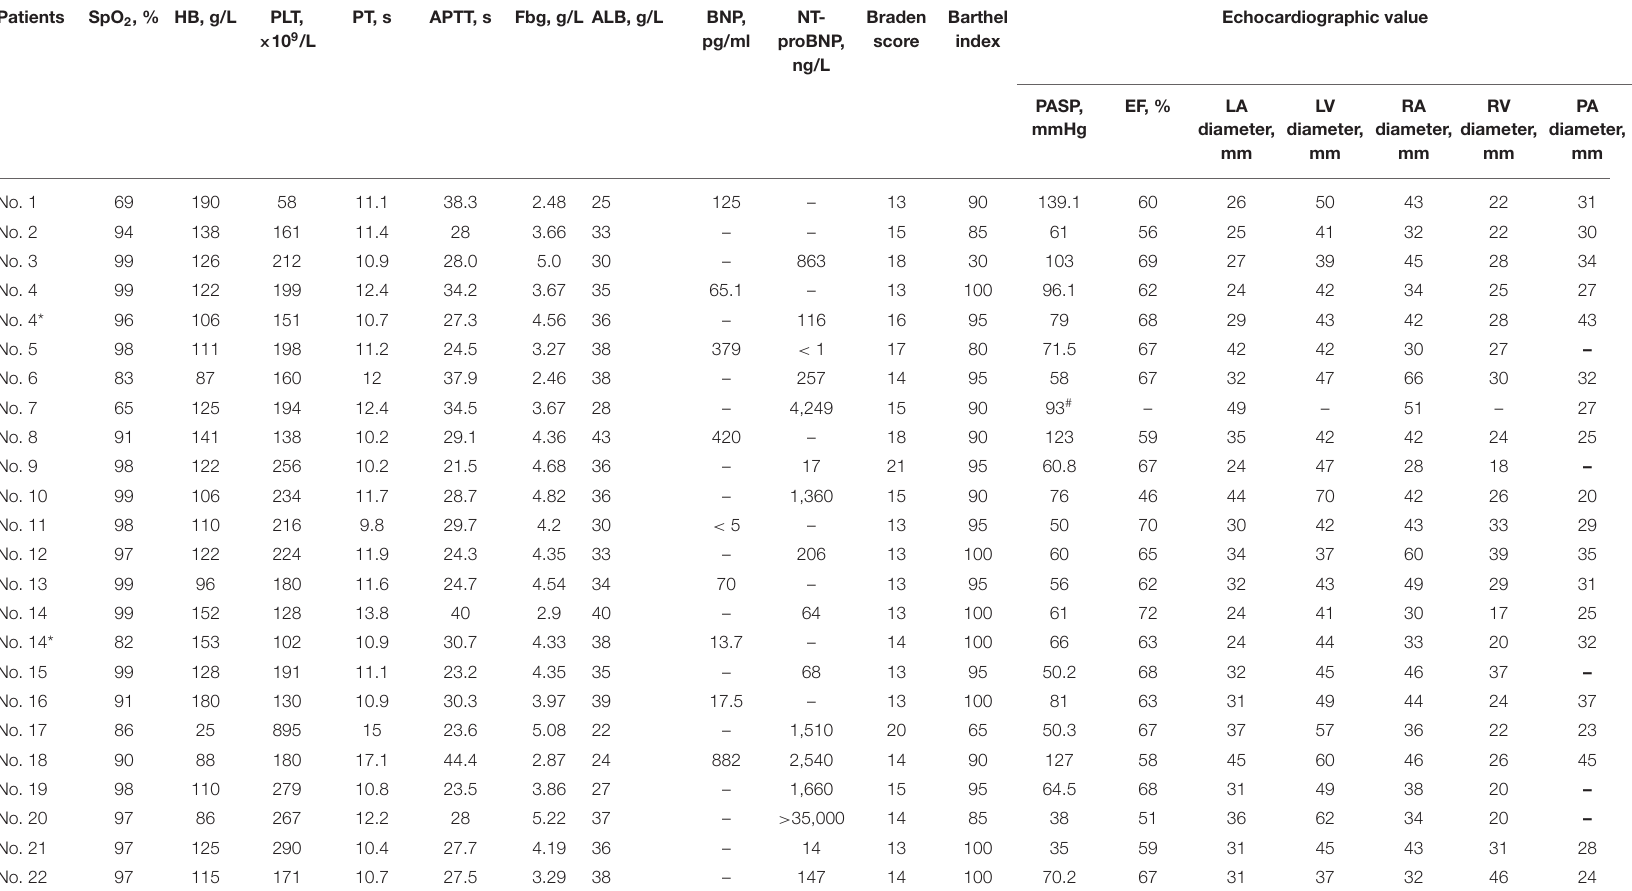
TABLE 2 | Examination indicators and echocardiographic value before termination or delivery in PAH patients with pregnancy. Patients SpO 2 , % HB,